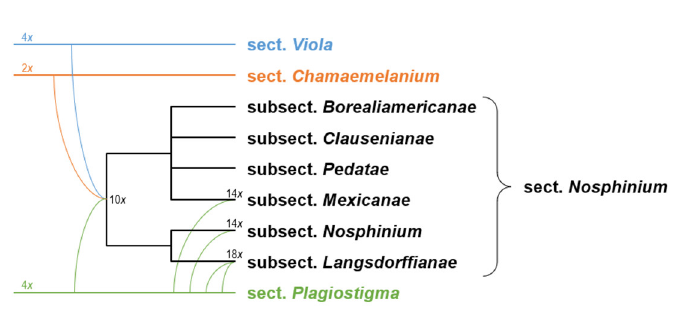
Figure 24. Reticulate allopolyploid phylogeny of Viola sect. Nosphinium , simplified from Marcussen et al. [45]. Allopolyploidisations are indicated by curved lines. Ploidy ( x ) is